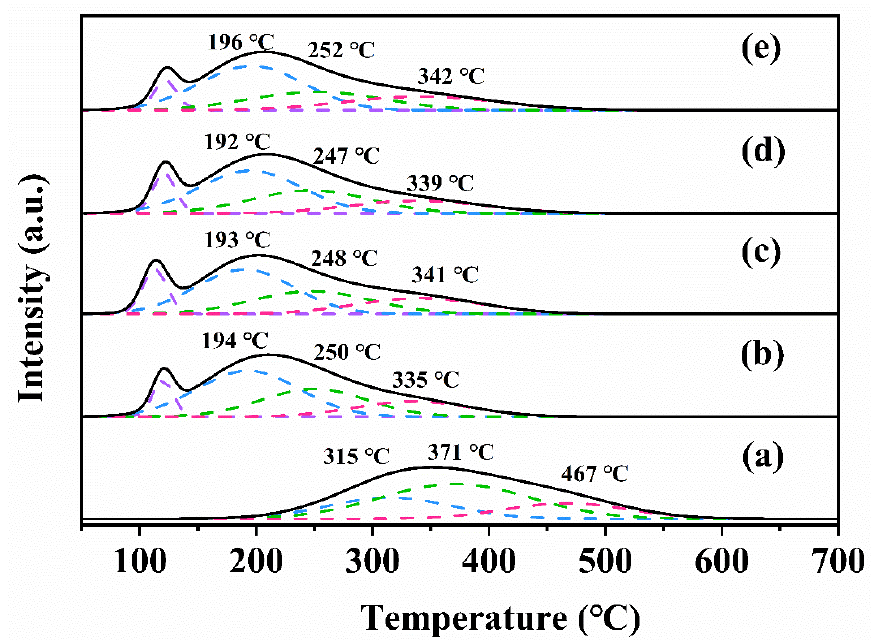
Figure 6. H 2 -TPR profiles of (a) α -MnO 2 , (b) 0.93Pt/ α -MnO 2 , (c) 0.91Pt-0.5rGO/ α -MnO 2 , (d) 0.94Pt- 1.0rGO/ α -MnO 2 , and (e) 0.92Pt-2.0rGO/ α -MnO 2 .